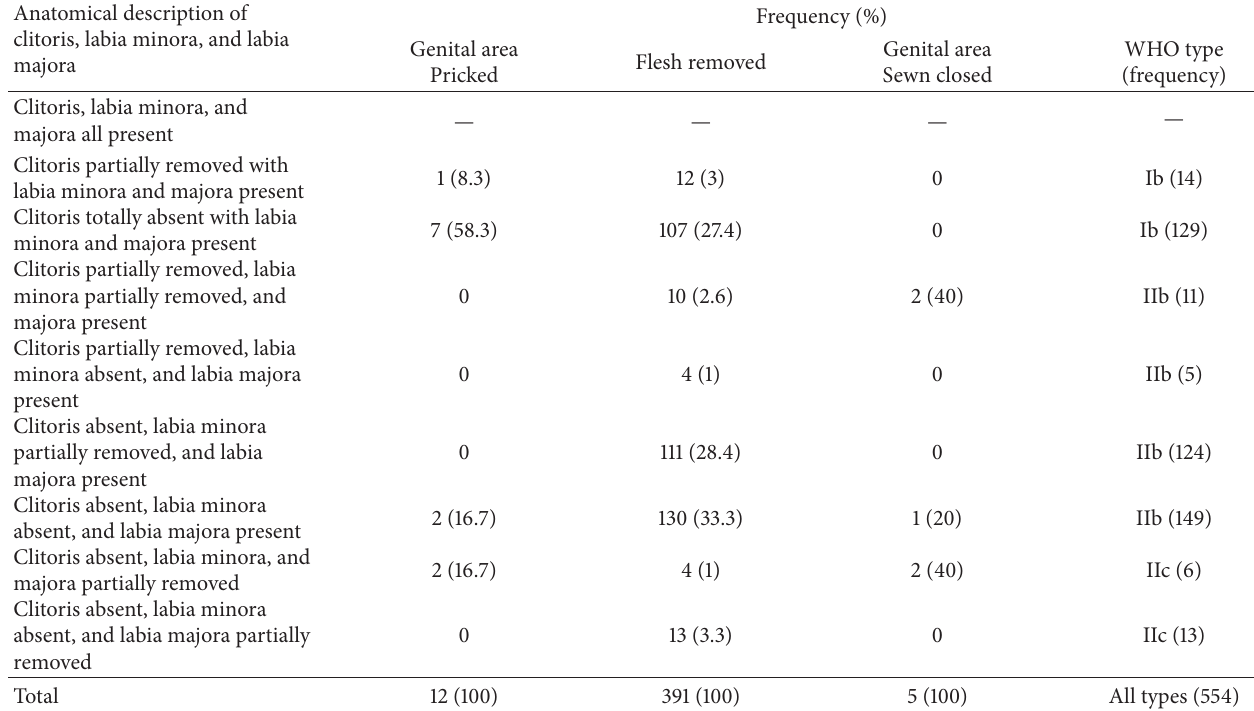
Table 7: Observed anatomical description versus respondents’ answers to DHS FGM questions describing operation performed on external genitalia: area pricked, flesh removed, or area sewn